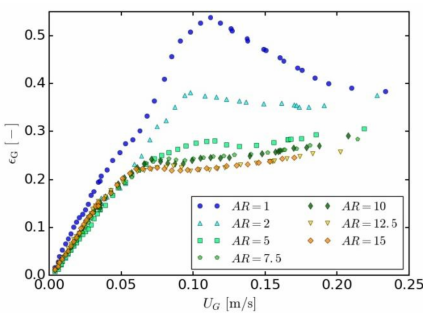
Figure 21. Influence of AR in large diameter bubble columns with spider sparger—data from ref.